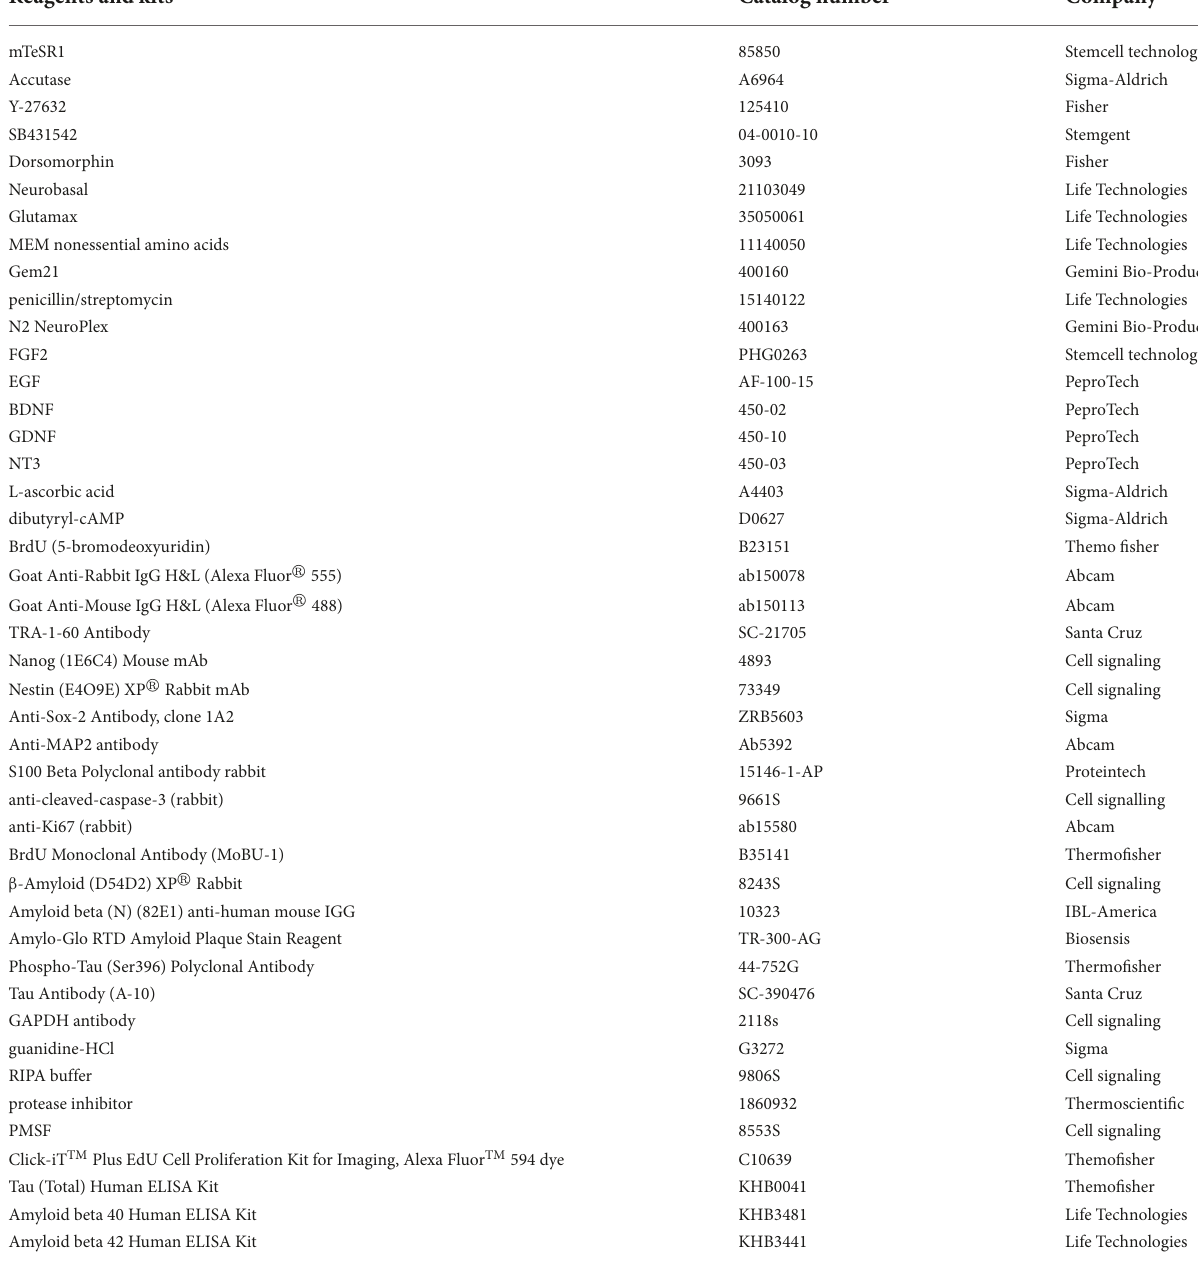
TABLE 2 List of reagents and chemicals. Reagents and